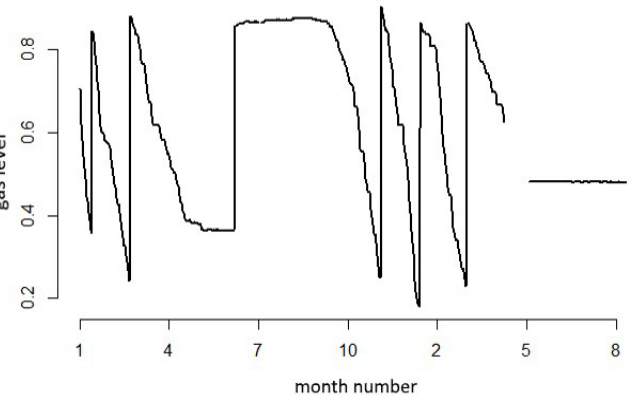
Figure 3. Gas level measurements over time represented as a fraction of the tank capacity over the consecutive months of the